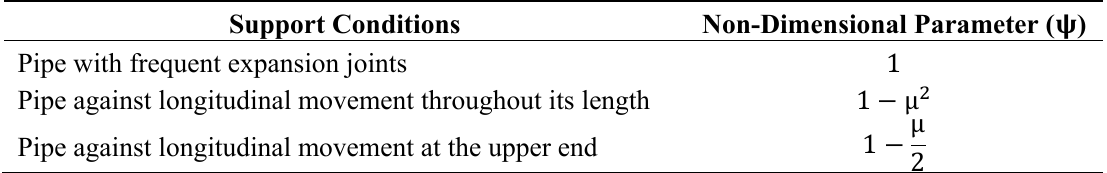
Table 2. Non-dimensional parameter associated to the support conditions.